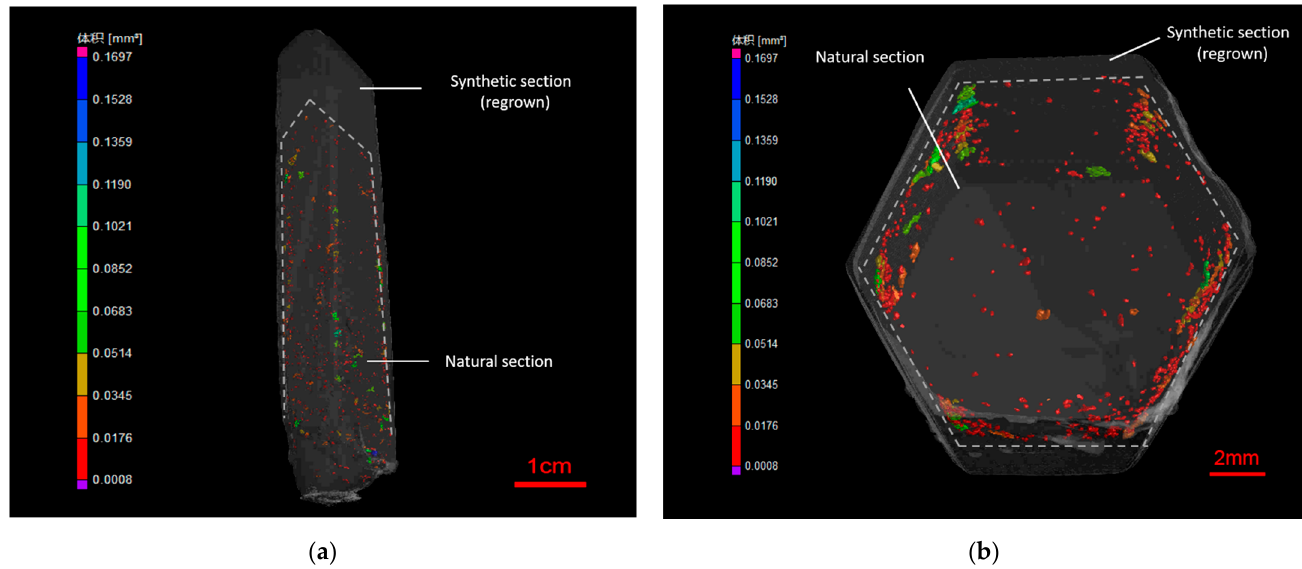
Figure 3. 3D images of microstructure characteristics of the regrown quartz crystal. ( a ) Side view image, ( b ) top view image. (inside the dotted line—the natural section; outside the dotted line—the synthetic section).